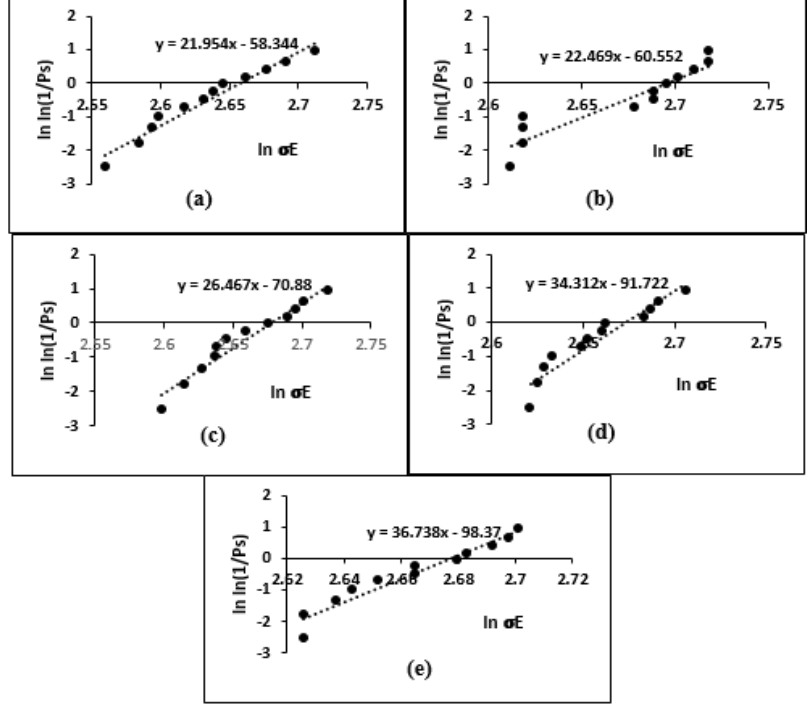
Figure 4: Weibull distribution of dielectric strength at various RRV: (a) 0.5, (b) 1, (c) 2, (d) 3 and (e) 5 kV/s, for 2 wt% Al 2 O 3